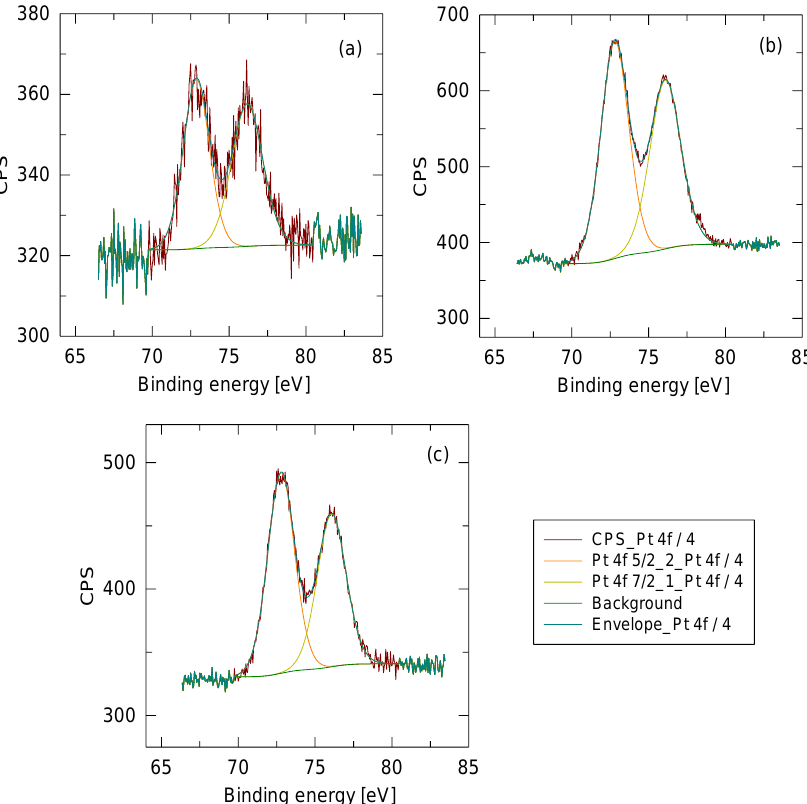
Figure 10. XPS spectra of the sample: ( a ) 0.08 Pt/PBI, ( b ) 0.54 Pt/PBI, ( c ) 0.68 Pt/PBI.